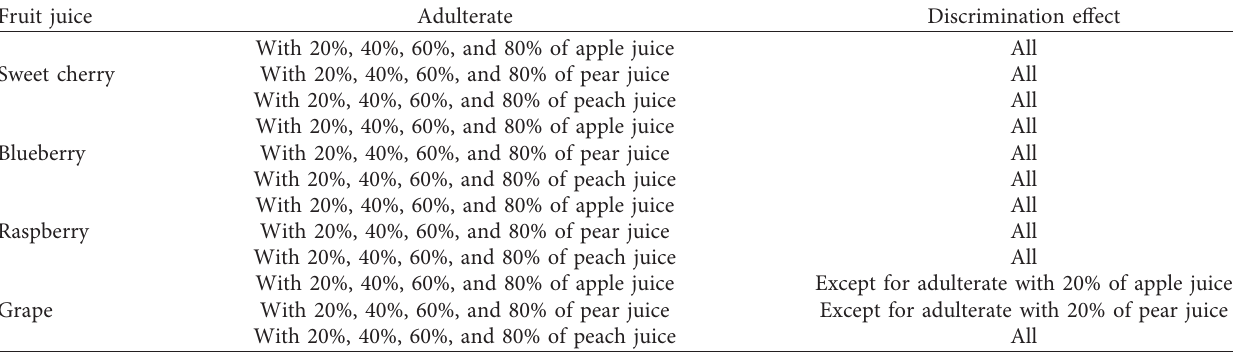
Table 4: Discrimination effect of adulterate samples by LDA with sugar and organic acid